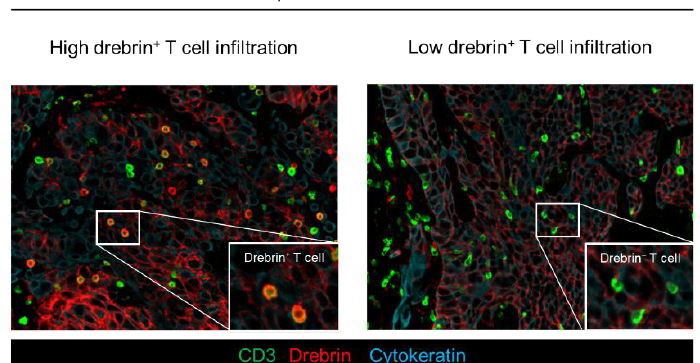
Figure 1. Drebrin expression detected in peripheral T cells and schematics of TIL analysis among patients with primary squamous cell cancer. ( A ) Representative images of the peripheral T cells. Purified T cells from healthy donors’ peripheral blood were stained with CD3 (green), drebrin (red), and DAPI (blue). Scale bars, 50 µm. ( B ) Schematics of the automated spatial analysis of the TILs. Surgical tissue specimens from patients with squamous cell lung cancer (N = 34) were stained by multiplex fluorescent immunohistochemistry, and images of all the tumor areas were analyzed. TIL, tumor-infiltrating lymphocyte.